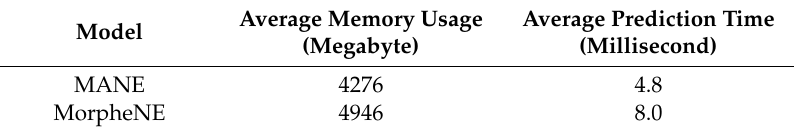
Table 7. Comparisons of memory consumption and prediction time.